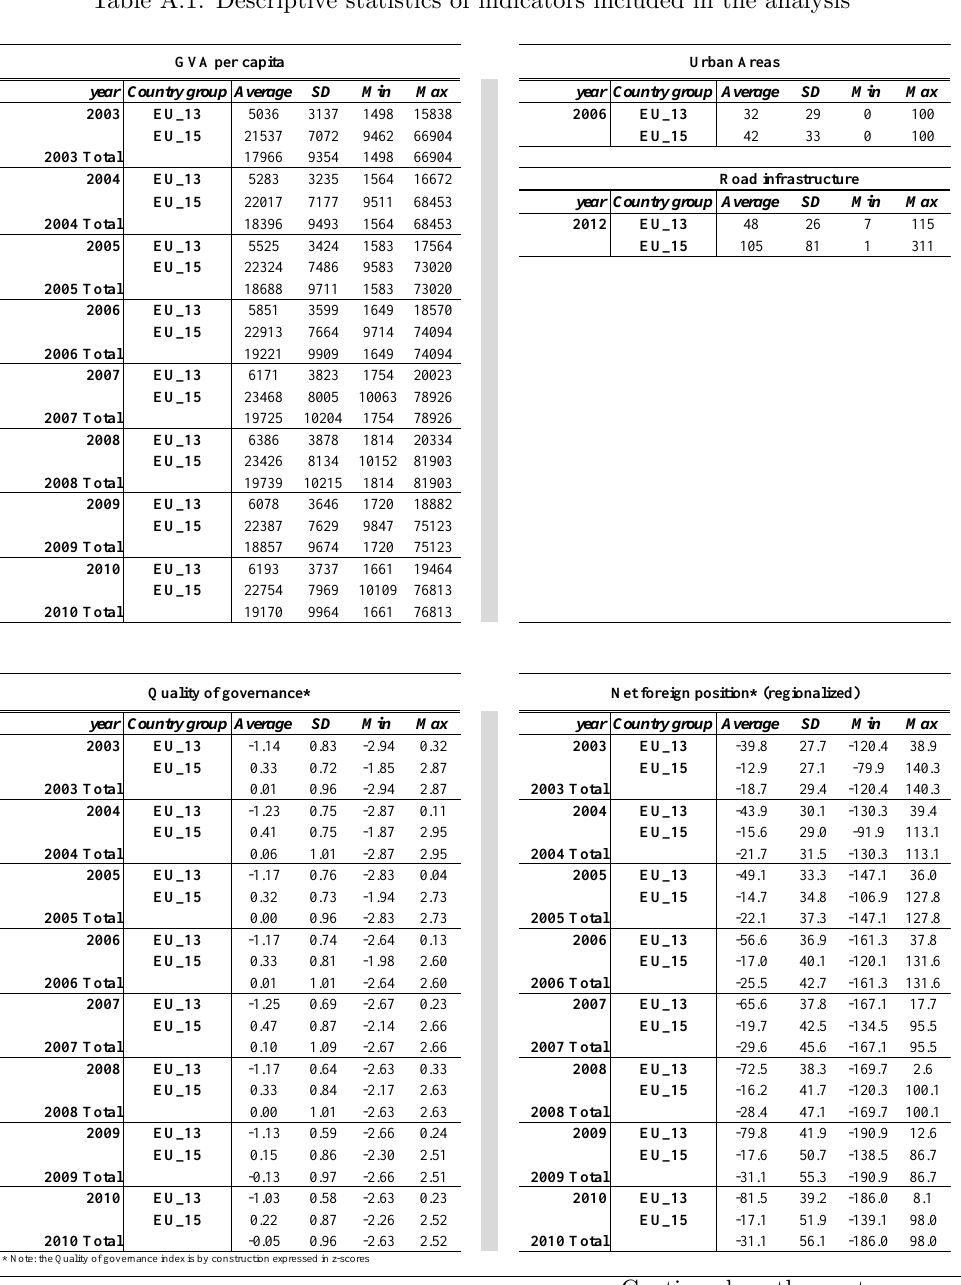
Table A.1: Descriptive statistics of indicators included in the analysis